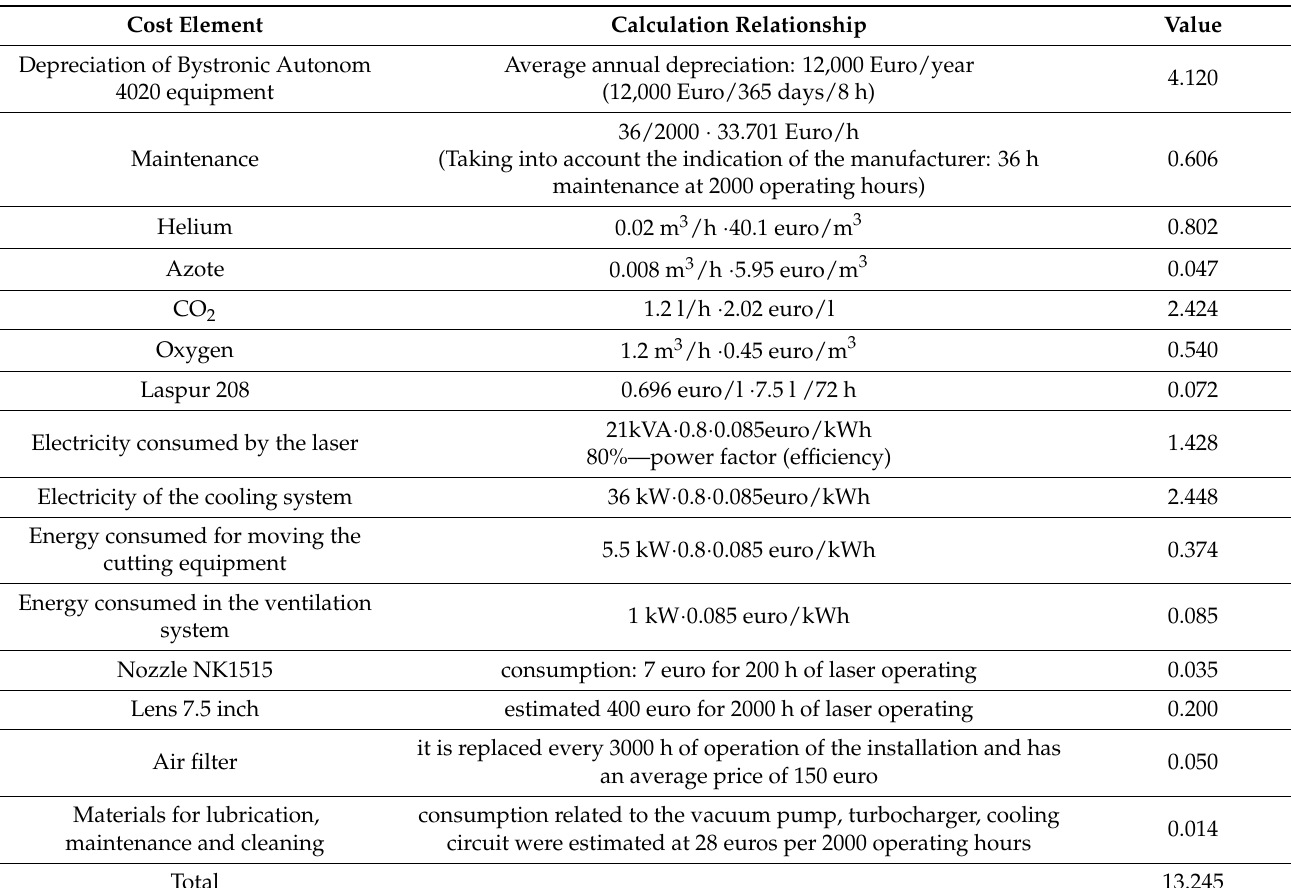
Table 4. Determination of the cost of the laser cutting machining process.